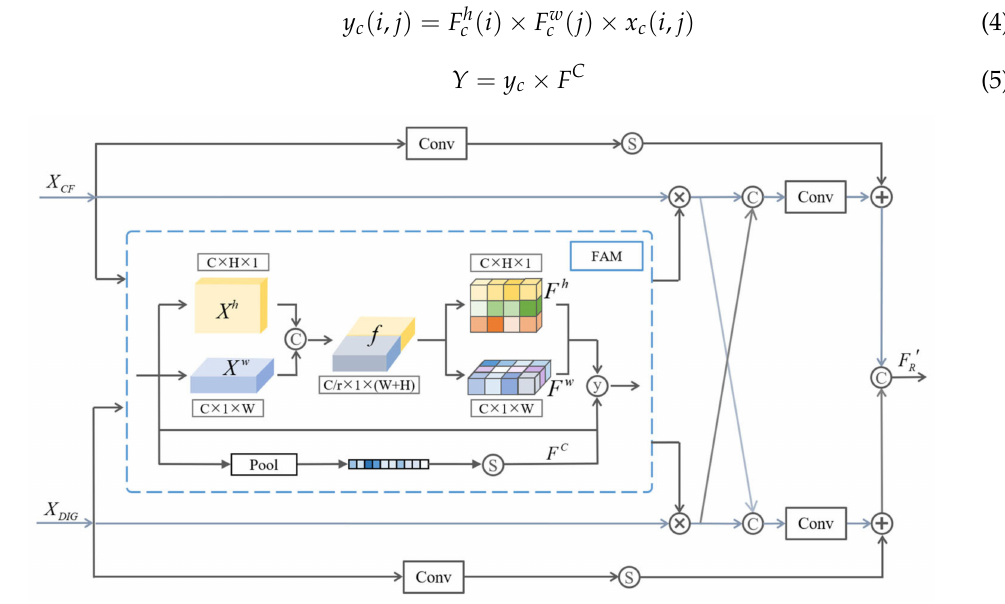
Figure 3. Detail feature supplement